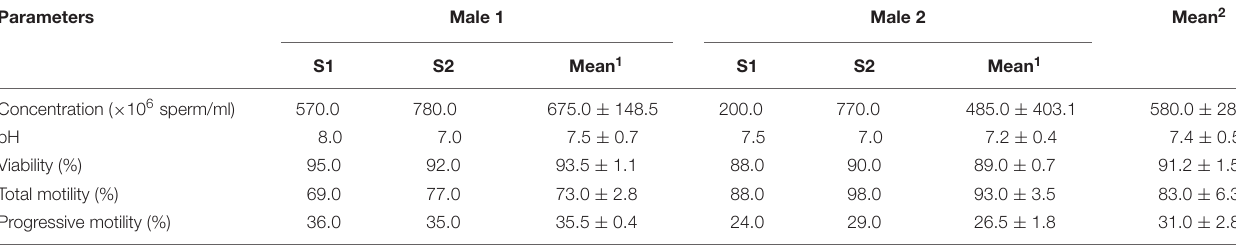
TABLE 1 | Seminal parameters of bottlenose dolphin males ( Tursiops truncatus ) used for proteomic analysis. Parameters